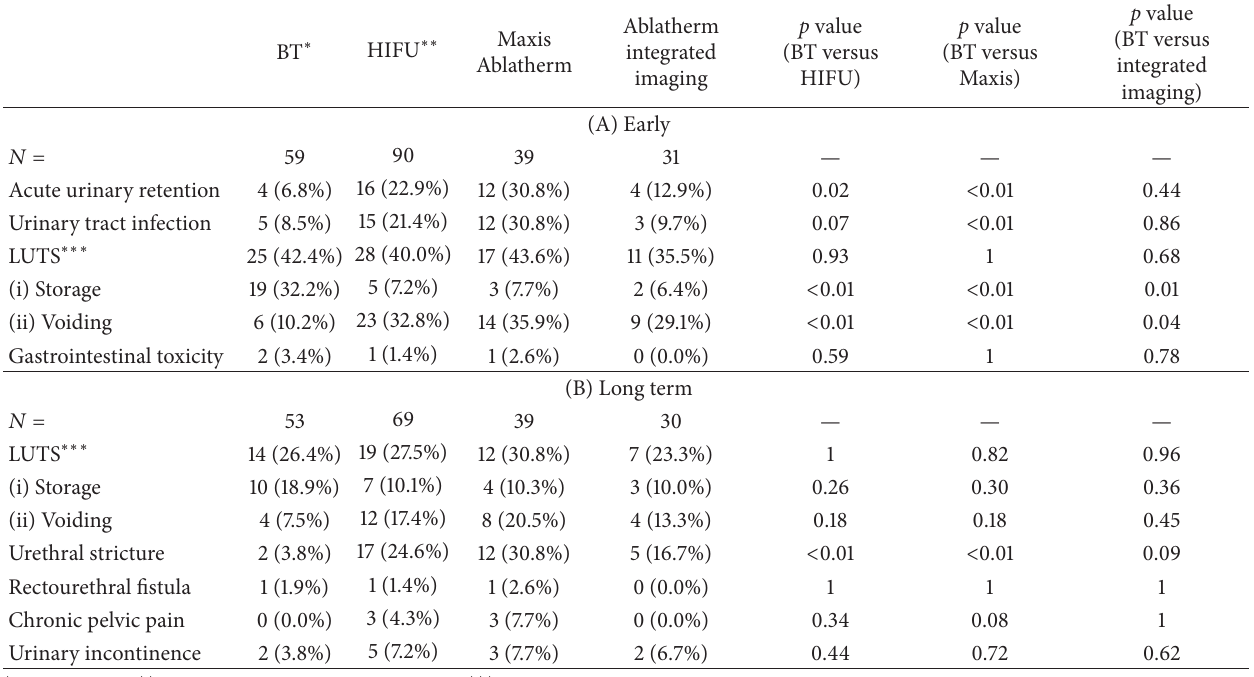
Table 4: Comparison of early and long term postoperative complications according to the therapeutic